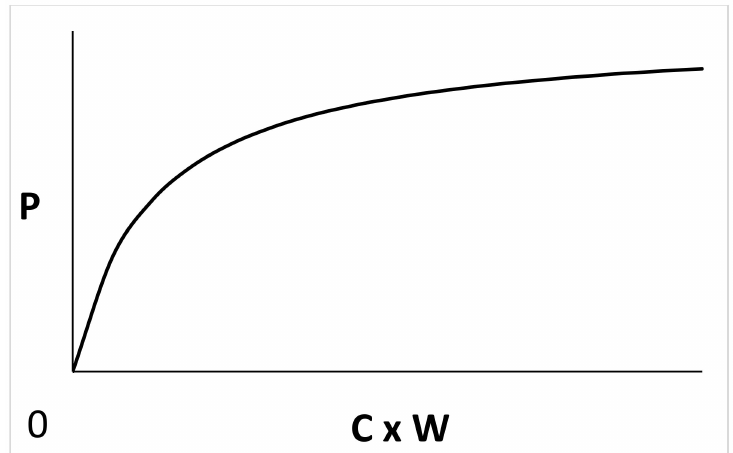
Figure 1. Logarithmic